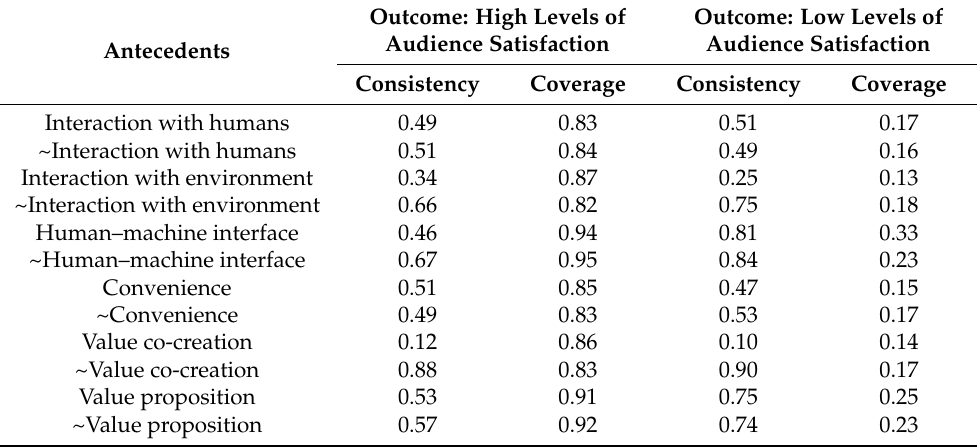
Table 5. Necessity analysis of single condition by